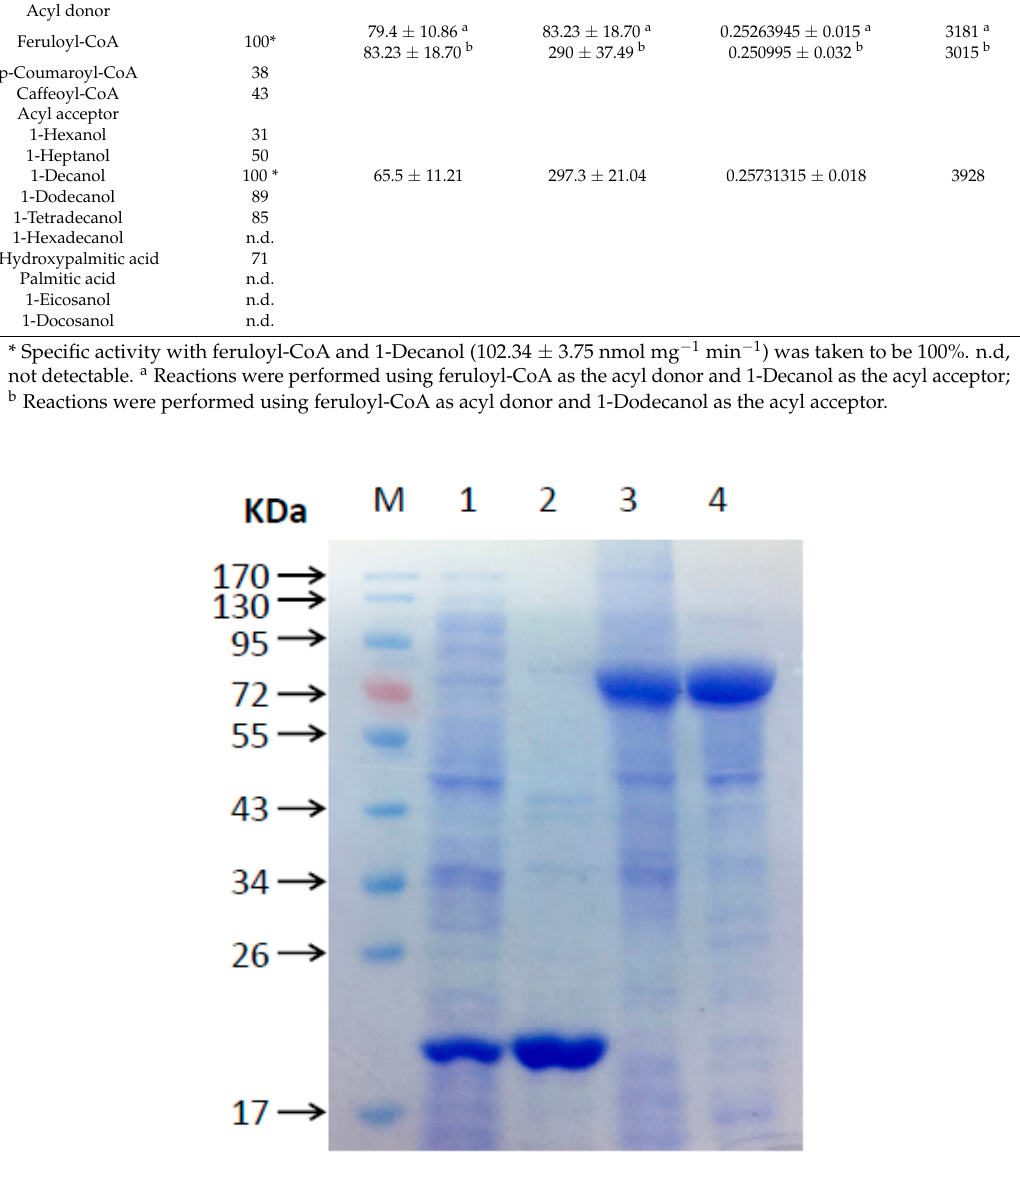
Figure 4. In vitro activity of MeHFT recombinant enzymes. ( A ) HPLC separation of the reaction products of recombinant MeHFT (the solid blue line) or the negative control (empty vector harboring cells) (the red dashed line) provided with feruloy-CoA and 1-dodecanol; ( B ) The MS/MS spectrum of the alky ferulate product from ( A ).